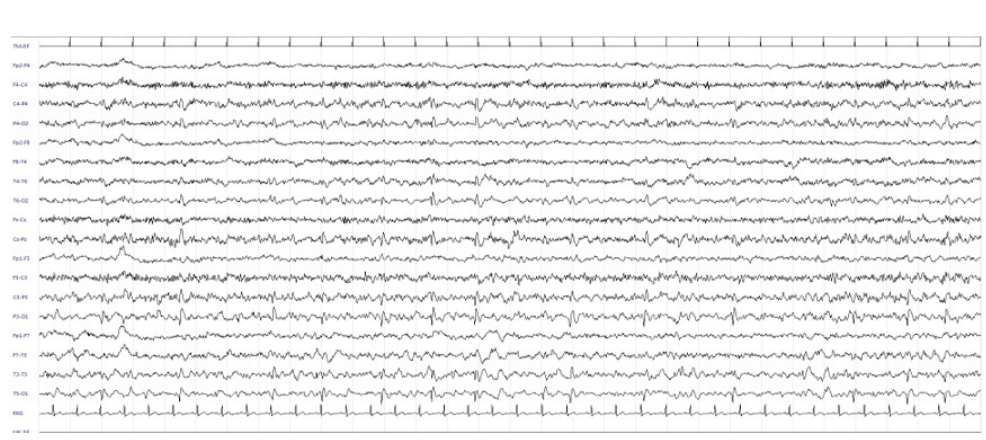
Figure 2. First EEG showing recurrent paroxysmal abnormalities in the right posterior regions with diffusion to the homologous contralateral regions with a periodic trend, which had not been observed in the tracing performed six months before during investigations carried out for RBD.